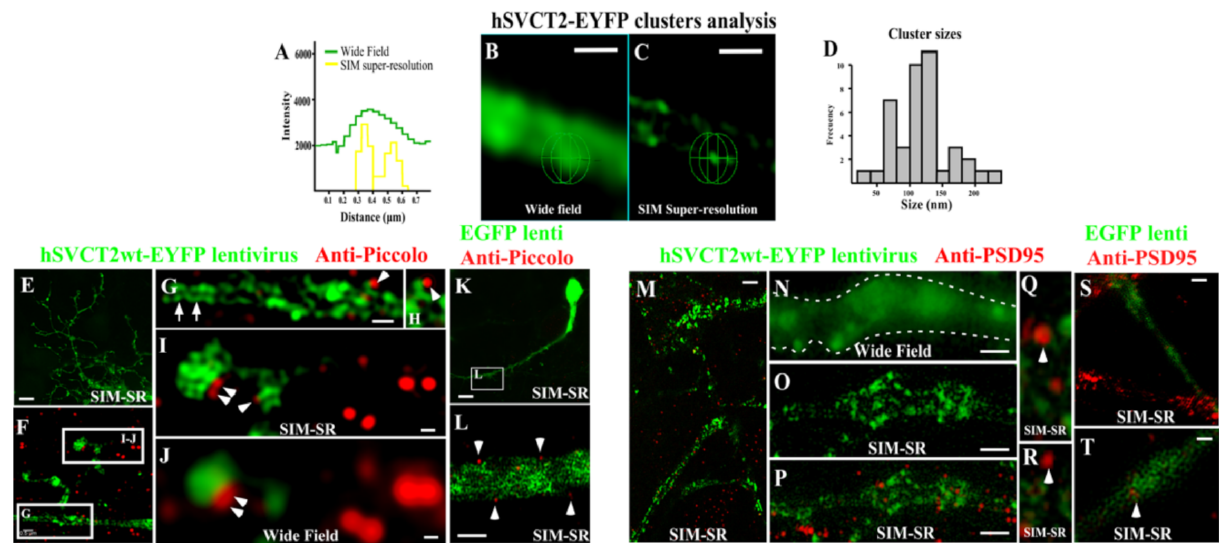
Figure 3. SVCT2 neuronal clusters are co-distributed with post-synaptic protein. ( A – D ) SIM Super-Resolution and Wide Field analysis of hSVCT2-EYFP cluster distribution and size in transduced neurons. ( E – L ) SIM Superresolution analysis to detect the colocalization between the green processes of neurons transduced with EGFP ( K , L ) or hSVCT2wt-EYFP ( E – J ) lentivirus and the piccolo presynaptic protein (red) ( F – J ) in cultures transduced for 48 h. ( M – T ) SIM Superresolution analysis to detect the colocalization between the green processes of neurons transduced with EGFP ( S , T ) or hSVCT2wt-EYFP ( M – R ) lentivirus and the PSD95 post-synaptic protein (red) ( O – R ) in cultures transduced for 48 h. Processes that overexpressed SVCT2 were also positive for PSD95 and in close proximity with piccolo-positive contacts (arrowheads). SVCT2 clustering on the plasma membranes was observed (arrows). ( S , T ) SIM Superresolution analysis to detect the colocalization between the green processes of neurons transduced with EGFP and PSD95 protein (red). Scale bars in ( B , C , F – J , L – N , P , S , T ), 0.5 µ m; ( E , K ), 10 µ